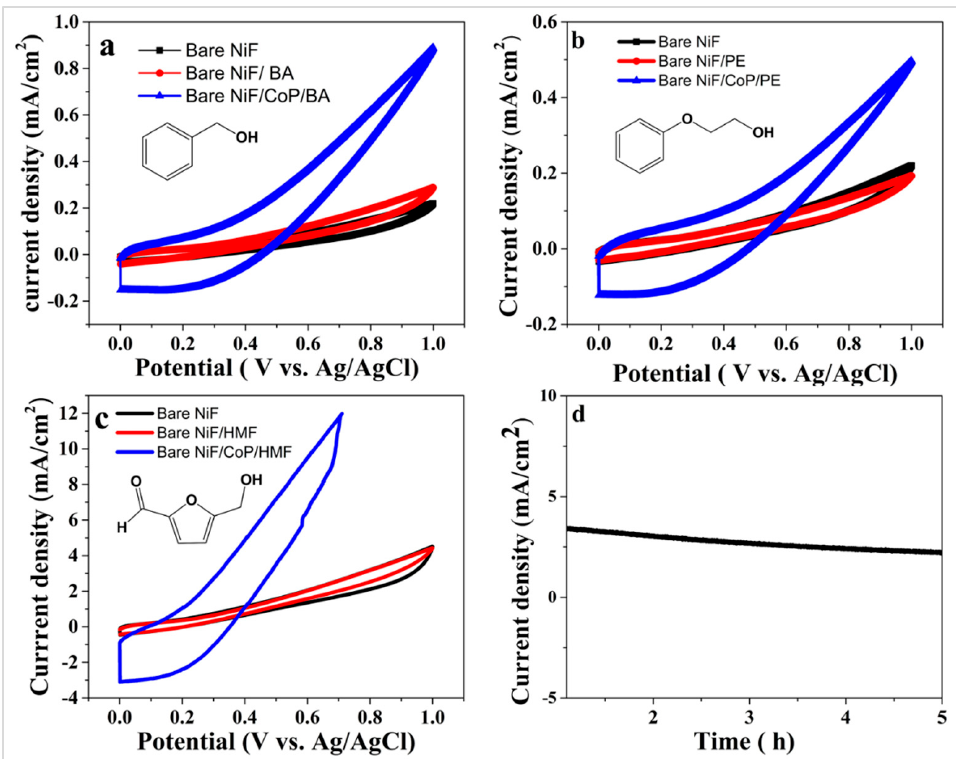
Figure 4. The CV of a different substrate of CoP@NiF electrocatalysts in 1.0 M KOH: ( a ) benzyl